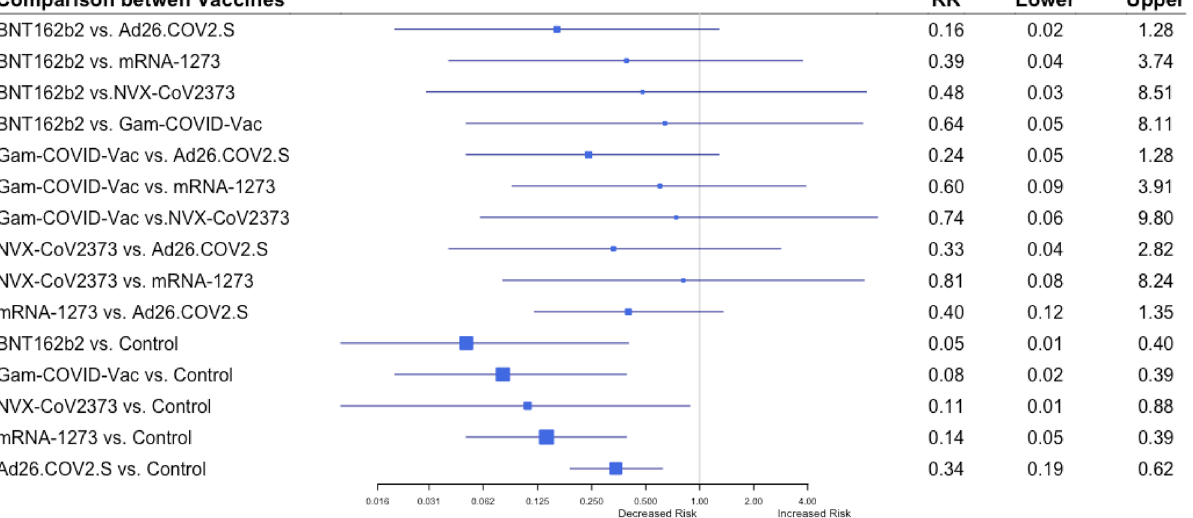
Figure 2. Results of random-effects network meta-analysis for efficacy to prevent symptomatic COVID-19 in subjects ≥ 60 years old: Risk Ratio (RR) for indirect comparison between the vaccines or vaccine vs. placebo, and 95% confidence intervals (Four studies